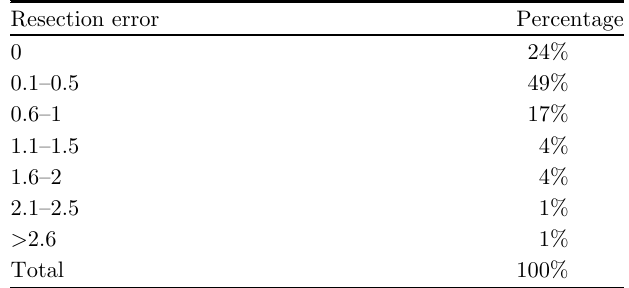
Figure 4. The tibial block was seated as per surgical plan and pinned. This is an intraoperative image showing the patient speci fi c cutting block placed on the proximal tibial surface which perfectly sat, once soft tissue was dissected off the bony surfaces for the contact points of the block. Tibial rotation and slope was double checked by extra-medullary alignment guide through the 3D block and the oblique pin placed before the cuts were made.